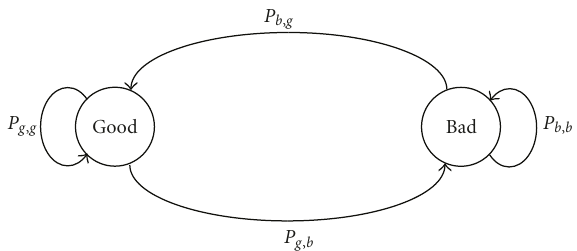
Figure 9: A two-state discrete Markov chain model for channel